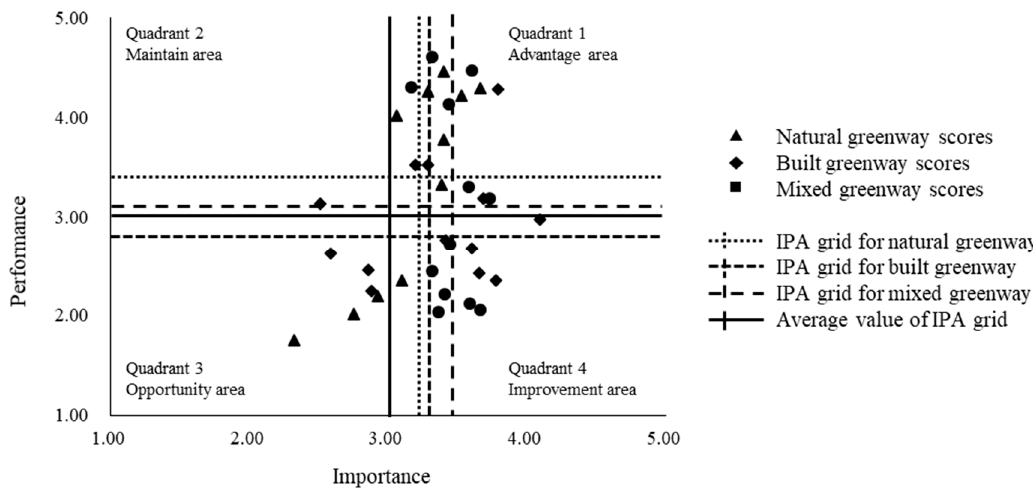
Figure 9. Importance–performance analysis grid of the three types of urban greenways.